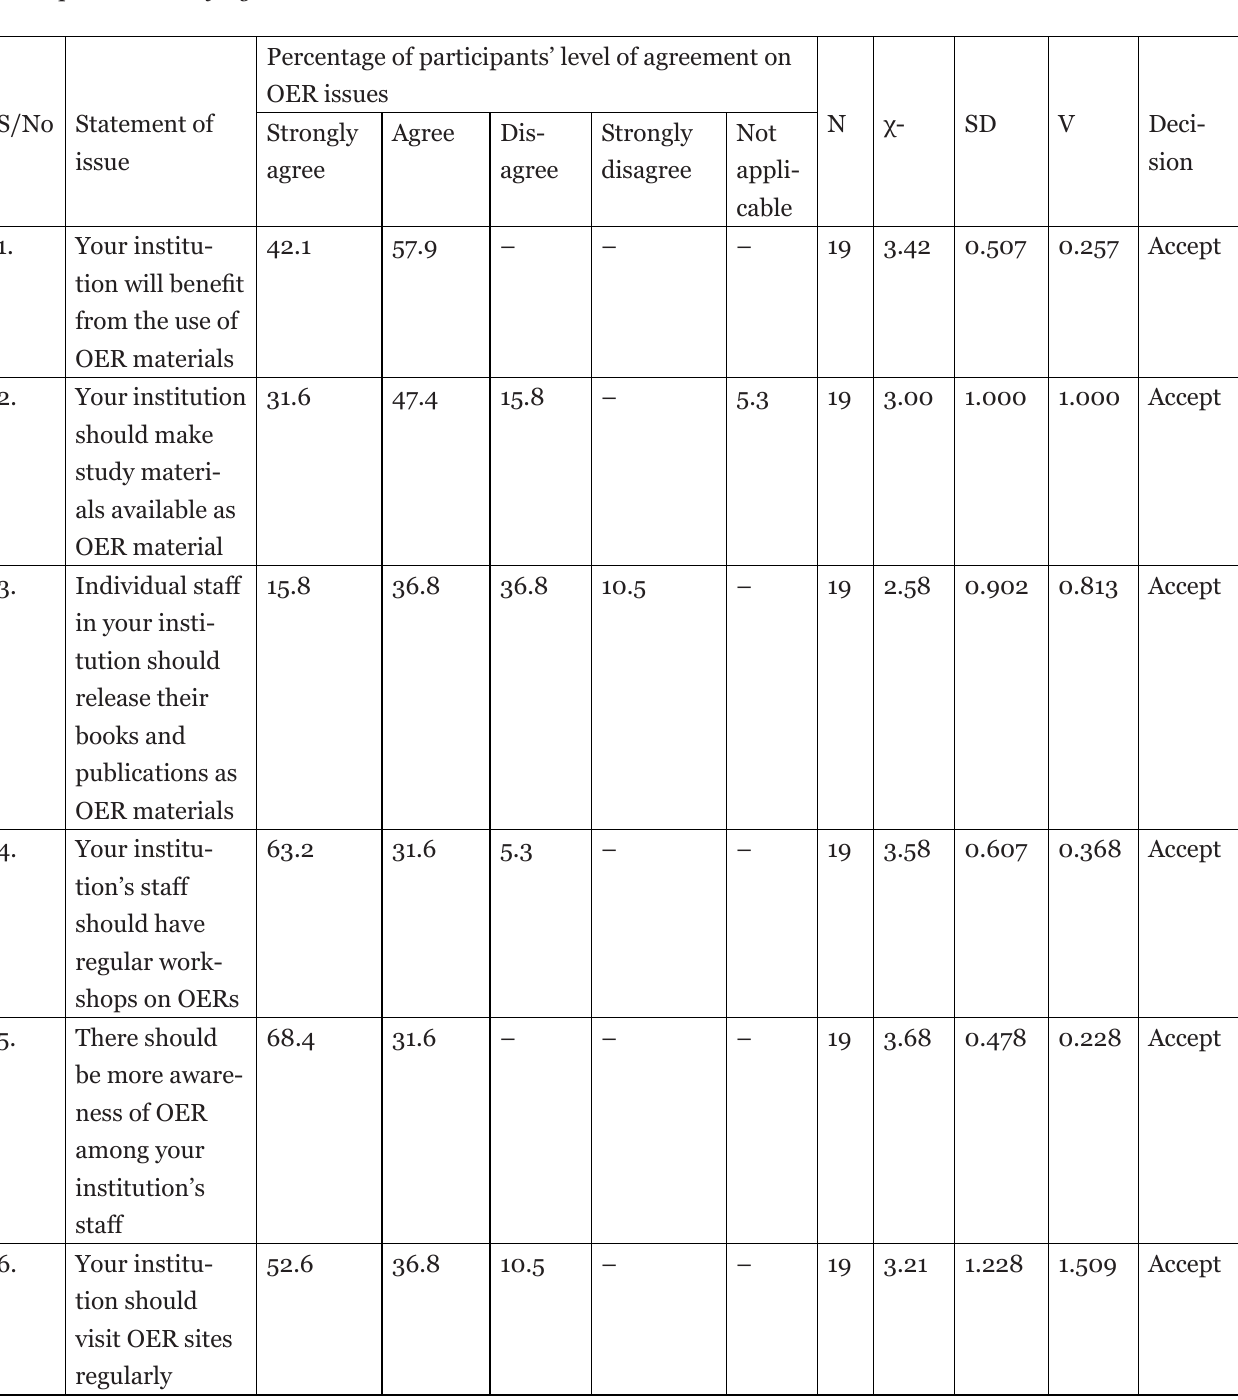
Table 4 Participants’ Level of Agreement to Relevant OER Issues